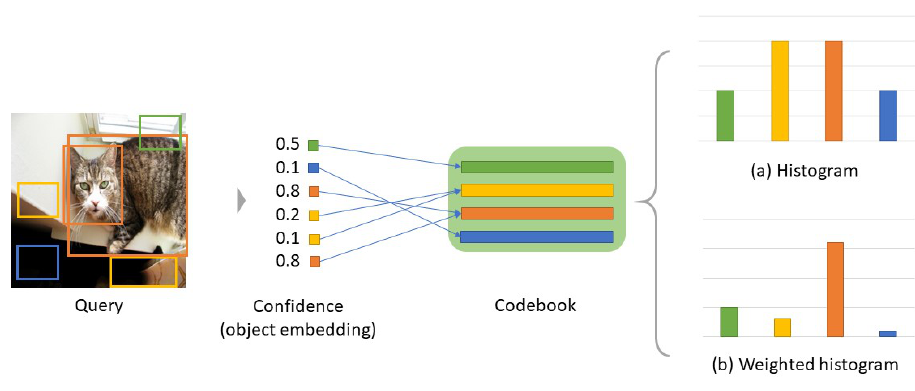
Figure 7. The overview of weighted histogram. Weights are applied when computing the histogram according to the confidence of each region.